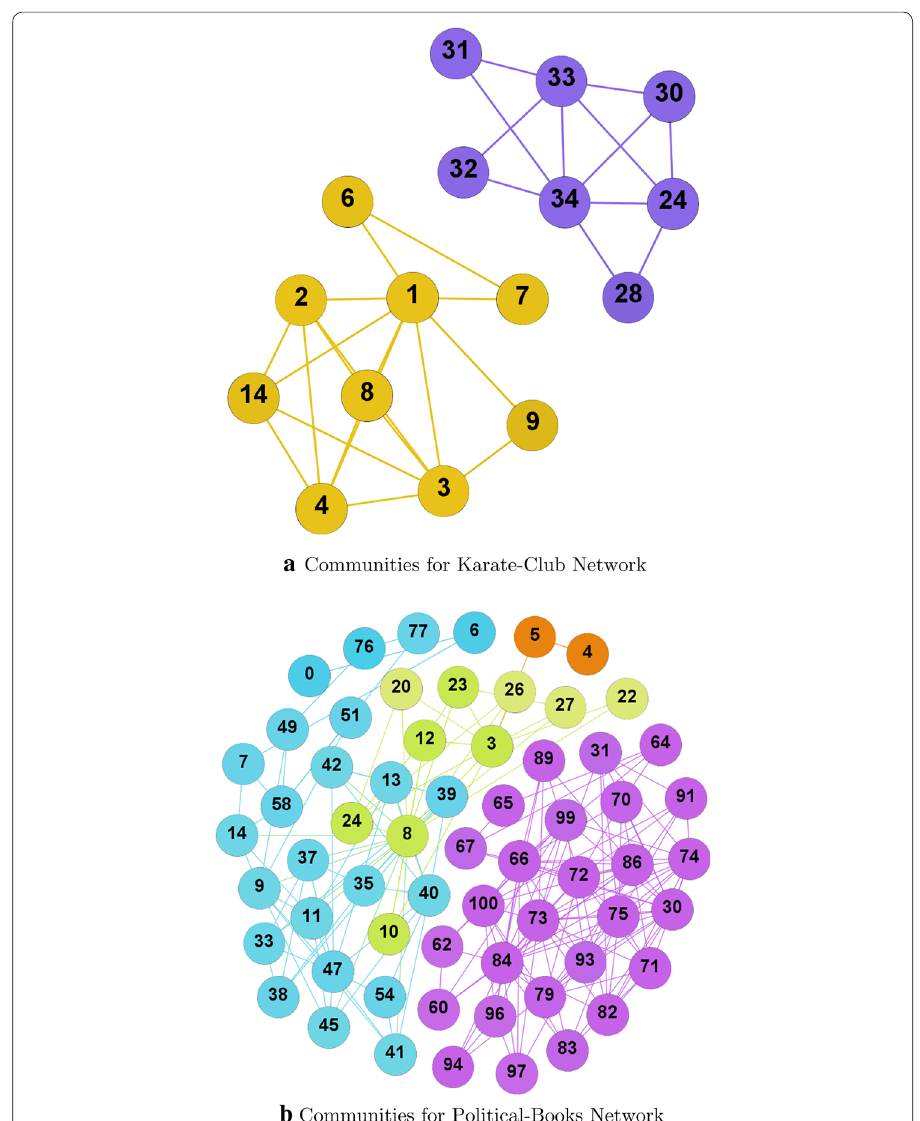
Fig. 5 Communities generated from ground-truth network dataset using proposed method. Communities generated for the sample ground-truth network datasets using the proposed